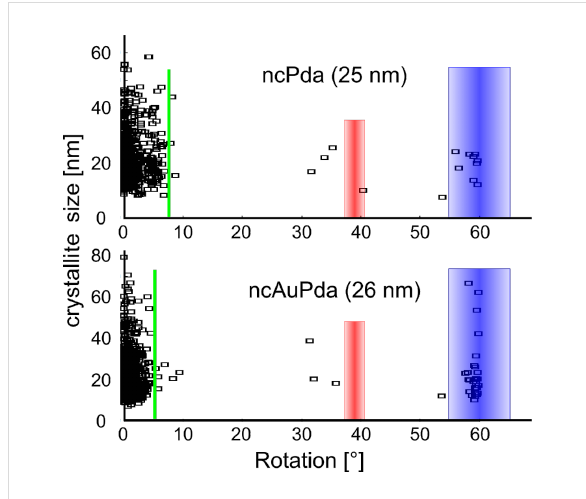
Figure 6: Crystalllite size versus lattice rotation plot of all tracked crys- tallites: (a) ncPda ( d A = 25 nm) (the green area of Figure 5a is evalu- ated), (b) ncAuPda ( d A = 26 nm). The green line indicates the rotation due to sample bending during straining. The Σ 9 (39 ± 1.7°) and Σ 3 (60 ± 5°) disorientations are marked in red and blue,